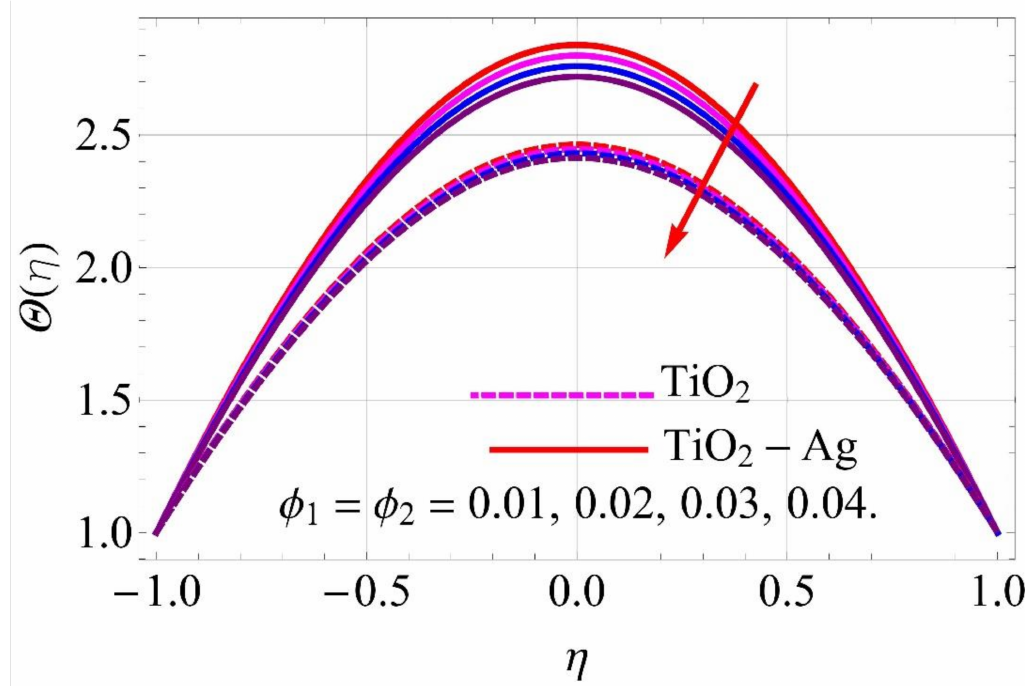
Figure 23. Temperature versus φ 1 , φ 2 with α = − 5 ◦ converging/stretching circumstances.